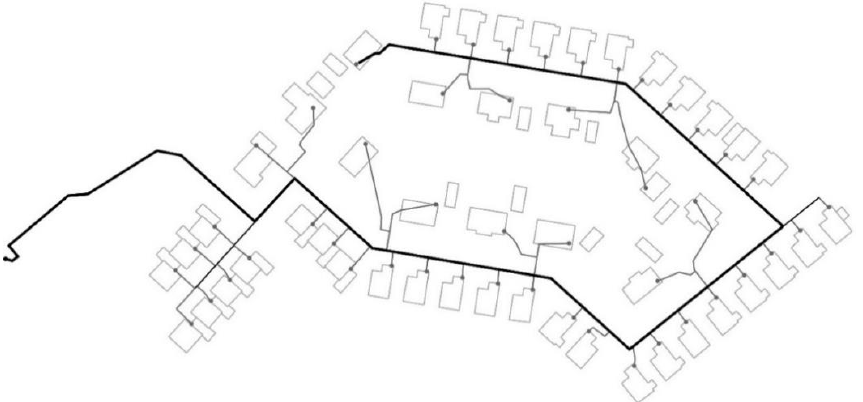
Figure 1. Network layout for the case area with the longest route is denoted with a thicker line. The connection point to the feeding distribution network is to the left.